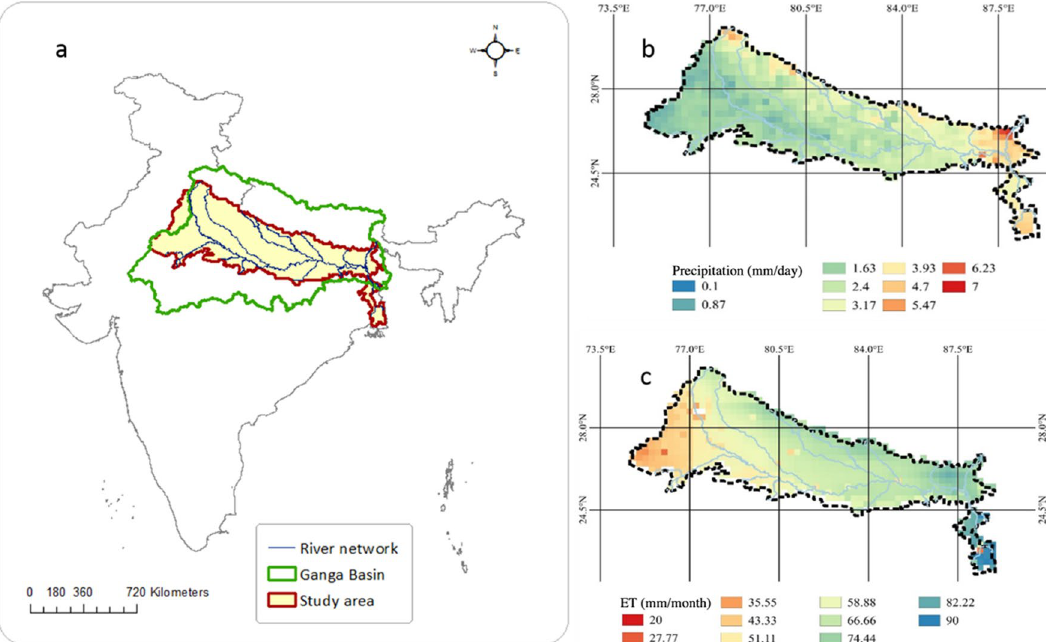
Figure 1. ( a ) Location of the study area within the Ganga Basin. ( b ) Mean precipitation during a period of 14 years from 2003 to 2016. ( c ) Mean evapotranspiration during a period of 14 years from 2003 to